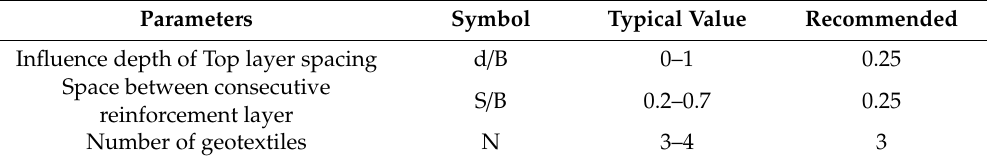
Figure 18. Variation in vertical stress and displacement/footing width (modified from Rashid et al. [15]).